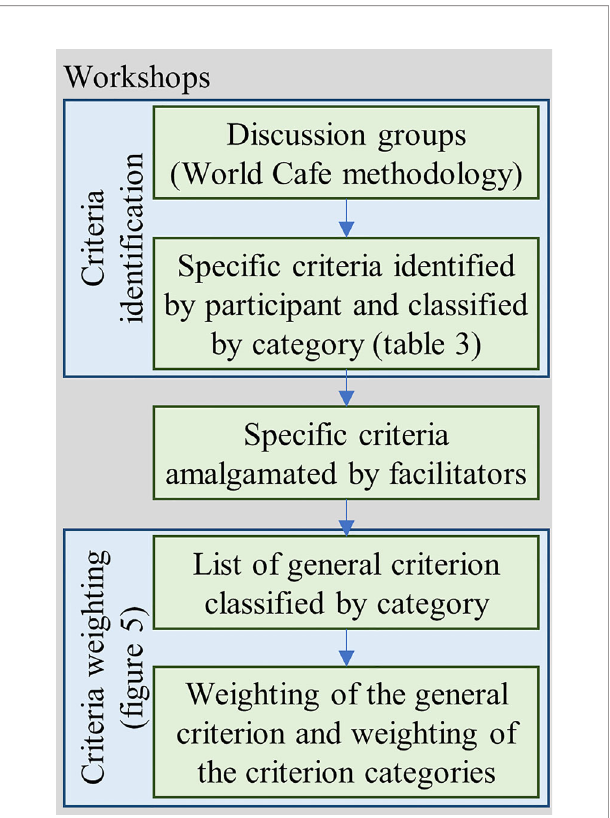
FIGURE 4 | Graphical representation of the method used for the implication of workshop participants in the identi fi cation and weighting of the CDMs selection